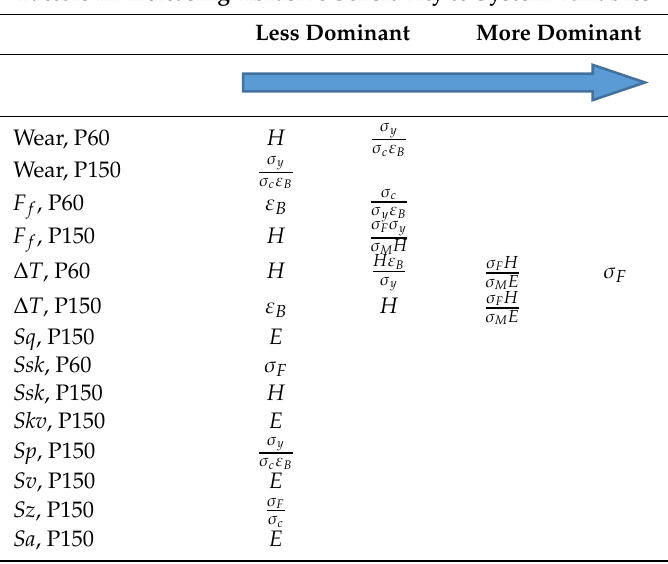
Table 9. Ranking the abrasive sensitivity to the system features.